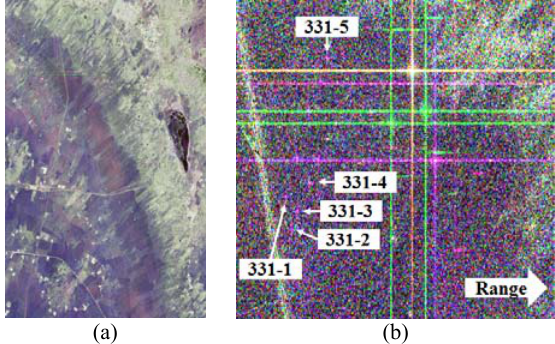
Figure 1. The GF-3 Pauli coding image. (a) The Inner Mongolia image and (b) is enlarge view of (a) with reflectors array.